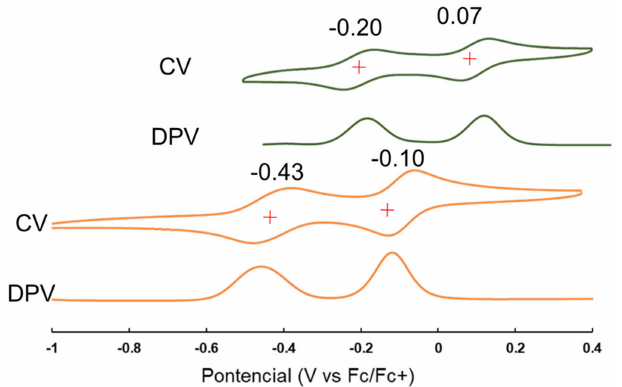
Figure 4. Cyclic and di ff erential pulse voltammograms (CVs and DPVs) of DEHPHAC 1a (orange) and